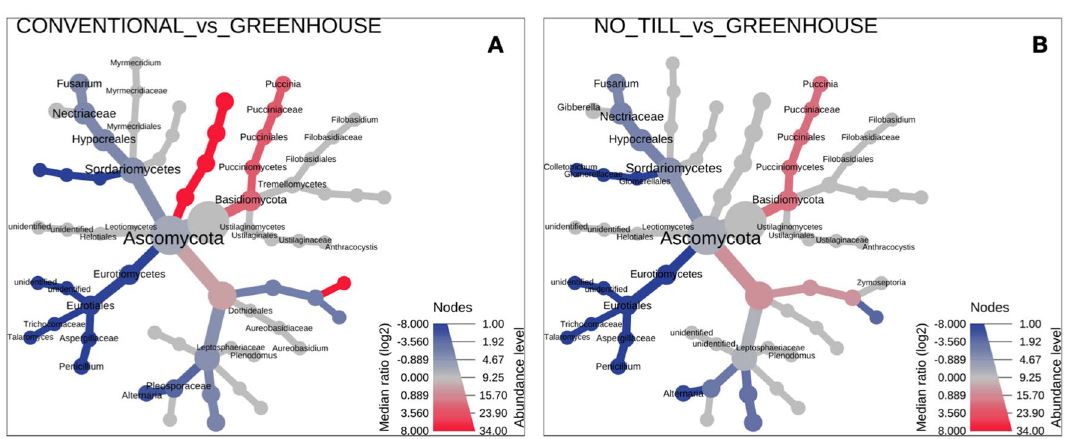
Figure 6. Heat tree visualization of taxonomic differences of endogenous fungi in various growth conditions. Blue and red nodes indicate the lower and higher abundance, respectively, compared to control. ( A ) Taxonomic differences in wheat cultivated in conventional conditions compared to the control plants (greenhouse). ( B ) Taxonomic differences in wheat cultivated in no_till conditions compared to the control plants